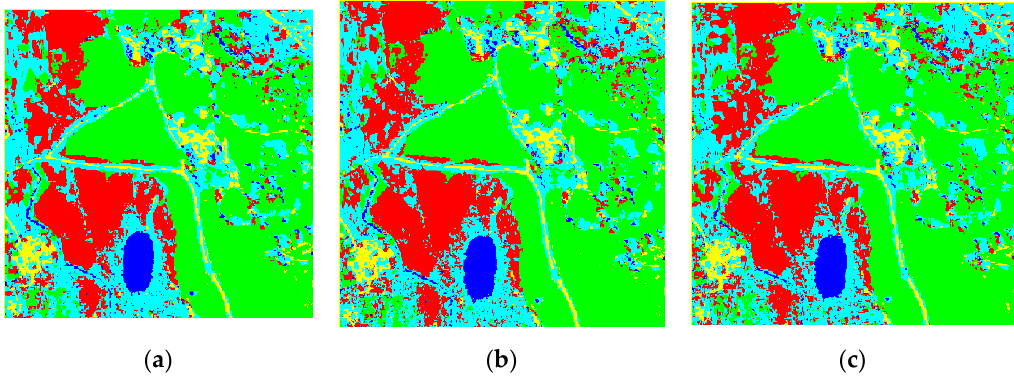
Figure 10. Classification results provided by NN-based method: for original image ( a ), for compressed image (PSNR-HVS-M = 36 dB) ( b ); for compressed (PSNR-HVS-M = 30 dB) ( c ).